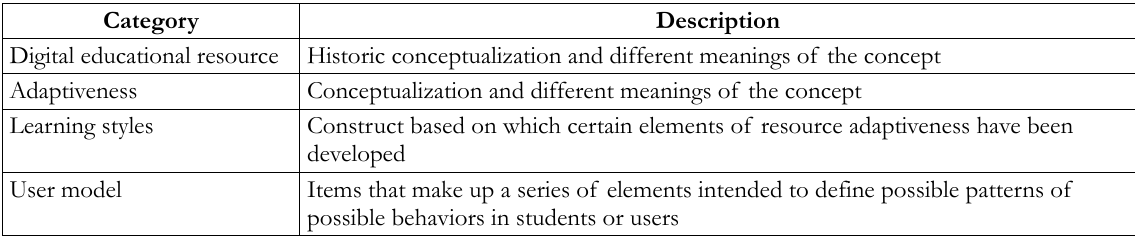
Table 2. Table of